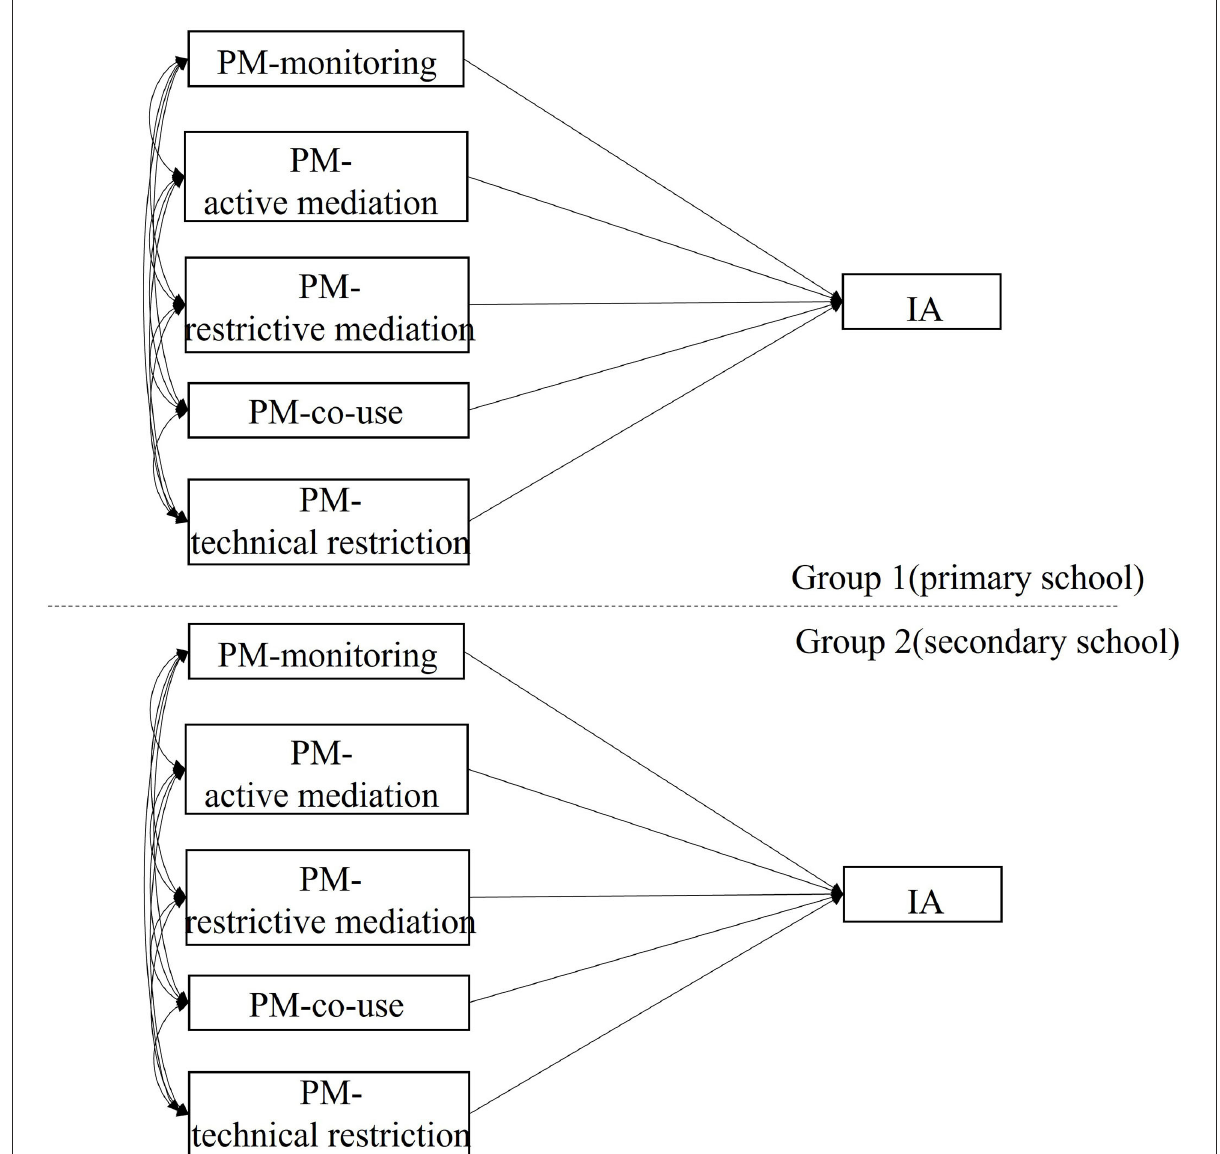
FIGURE3 Schematic representation of multi-group comparison model investigating group difference in the effects of PM on IA. The group was set as a categorical variable indicating membership of grade groups.